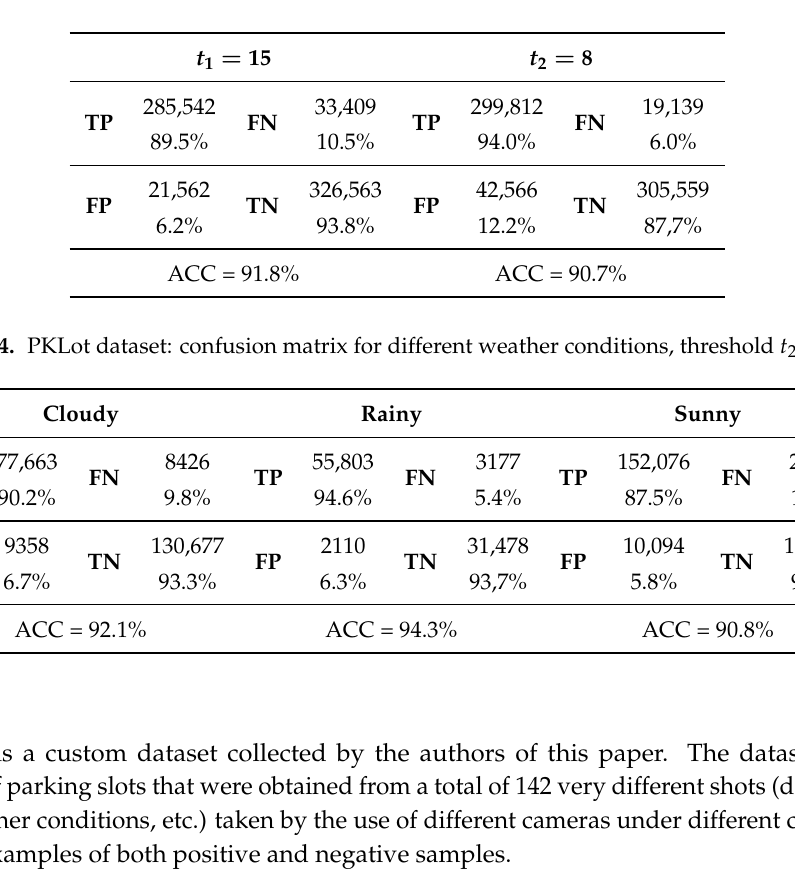
Figure 8. Statistical evaluation of algorithm performance ( a ) Threshold influence to the classification false rate; ( b ) Threshold influence to accuracy (ACC) of the classification. Table 3. PKLot dataset: confusion matrix for two different thresholds.